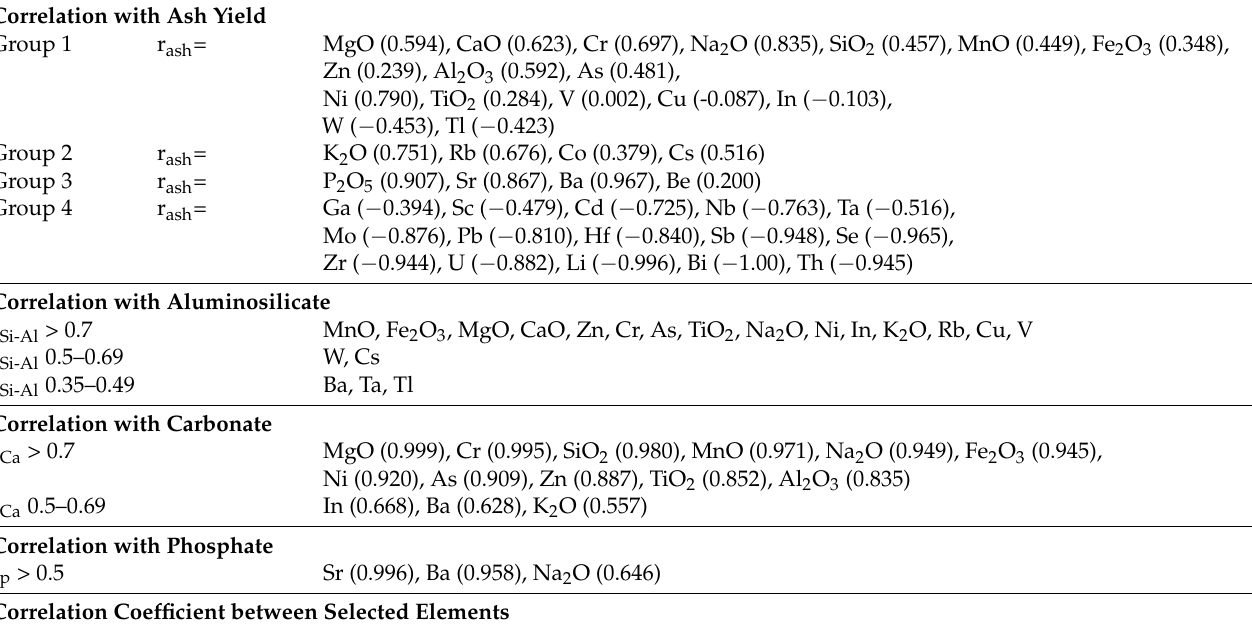
Table 9. Pearson’s correlations between elements and ash yields and selected